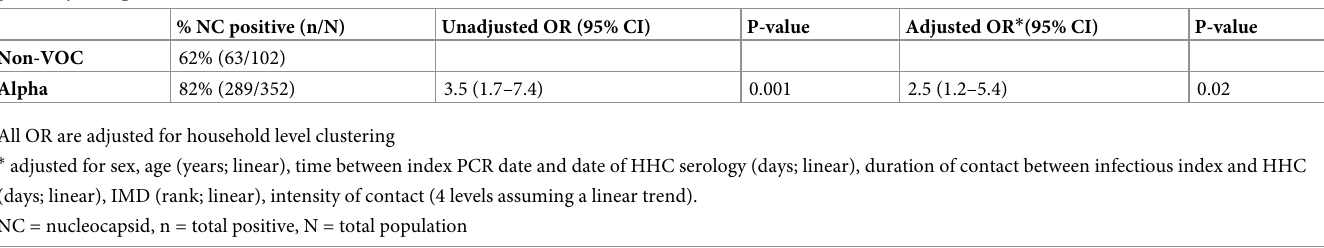
Table 3. Unadjusted and adjusted odds ratios for the effect of index case Alpha SARS-CoV-2 on household contact infection (defined as anti-nucleocapsid IgG sero- positivity) compared to